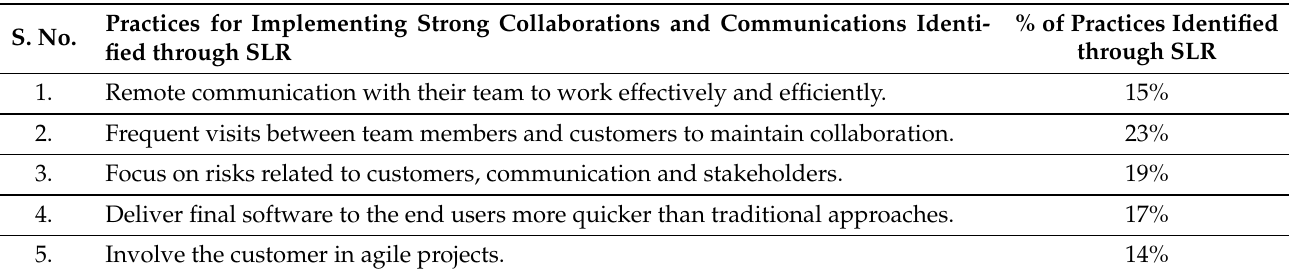
Table 15. Practices for implementing strong collaborations and communications.